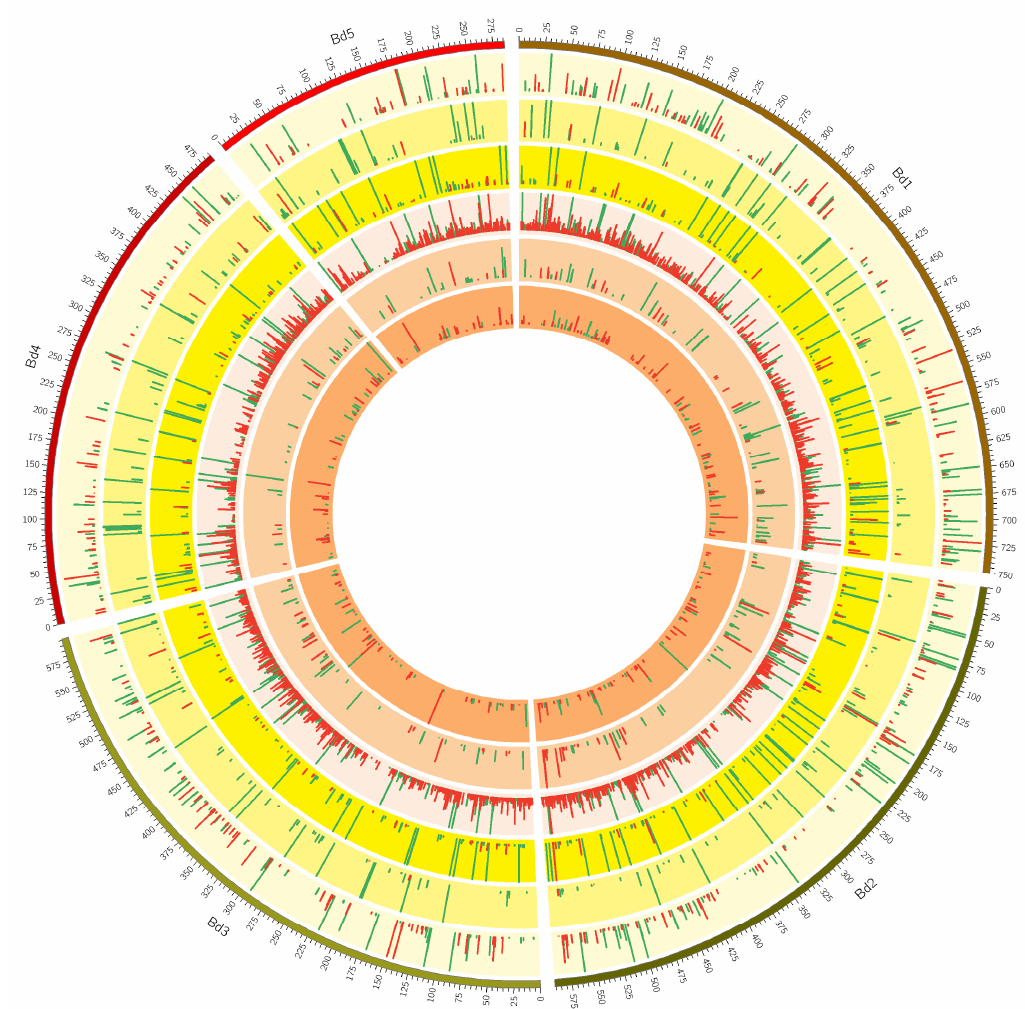
Figure 2. A Circos plot showing the distribution of >2-fold differentially expressed genes (DEGs) over the five Brachypodium distachyon cromosomes (track 1: Bd1-Bd5). Histogram sizes correspond to log2-fold-change with green indicating upregulation and red down-regulation upon drought stress. The three outer yellow rings (tracks 2, 3 and 4) depict DEGs for Brachypodium distachyon genotypes KOZ1, ABR8, and ABR4 respectively (outer to inner) in response to drought stress after 4 days (T1). The three inner orange rings (tracks 5, 6 and 7) depict the DEGs for these three genotypes after 8 days (T2) of withholding water.